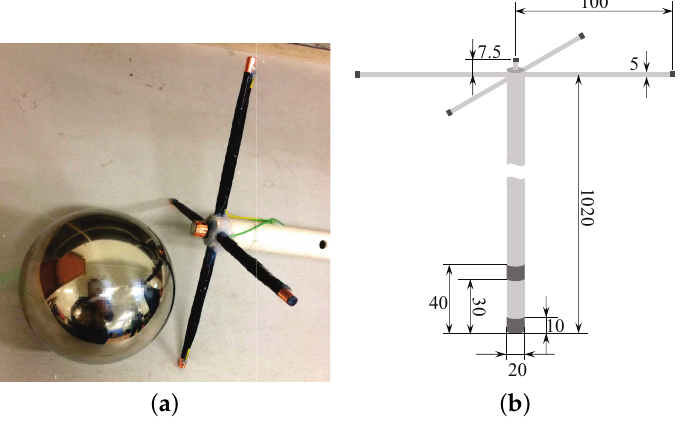
Figure 13. ( a )The image of the UCA system with the conductor target; ( b ) the physical size of the UCA system (units: